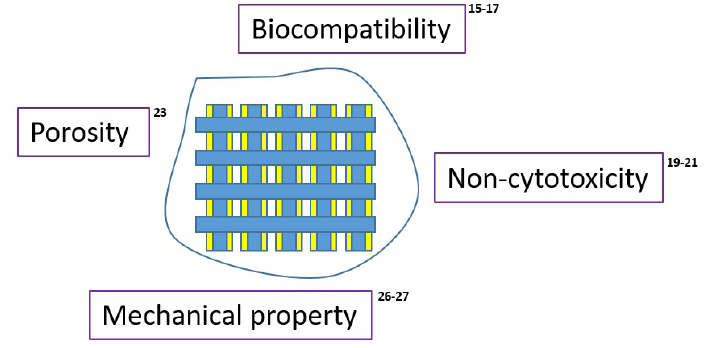
Figure 2. Main features of